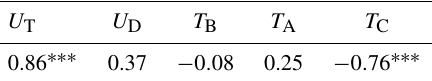
Table 3. Correlation coefficients between weekly averaged in situ parameters and the difference, (cid:49)h , of SLA values between the two selected altimetry grid points (Fig. 4). All parameters have been linearly de-trended before correlation. ∗∗∗ indicates statistical sig- nificance ( p < 0 . 001) as detailed in Sect.